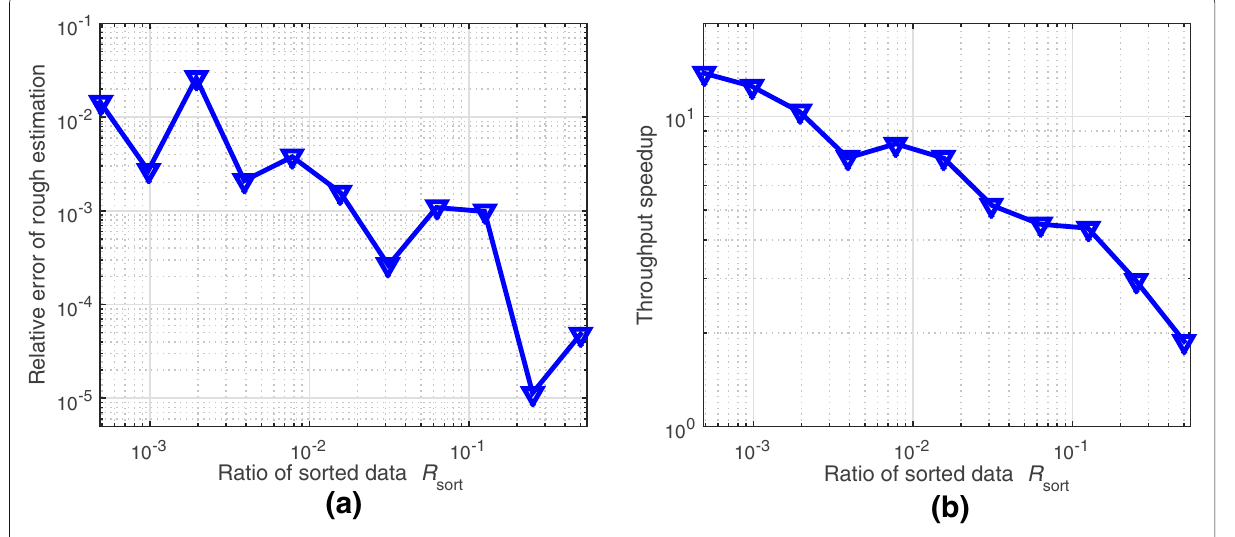
Fig. 5 a , b Relative error and throughput speedup for varying values of R sort in the RE